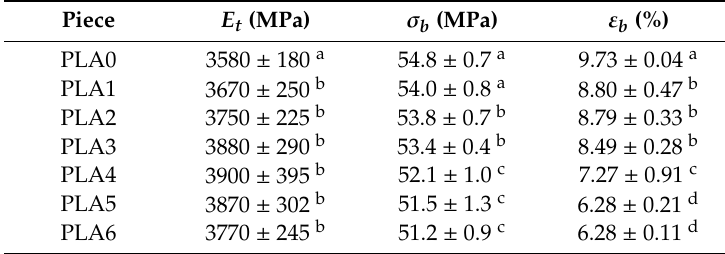
Table 1. Mechanical properties of the injection-molded polylactide (PLA) pieces subjected to di ff erent reprocessing cycles in terms of: tensile modulus (E t ), strength at break ( σ b ), and elongation at break ( ε b ).